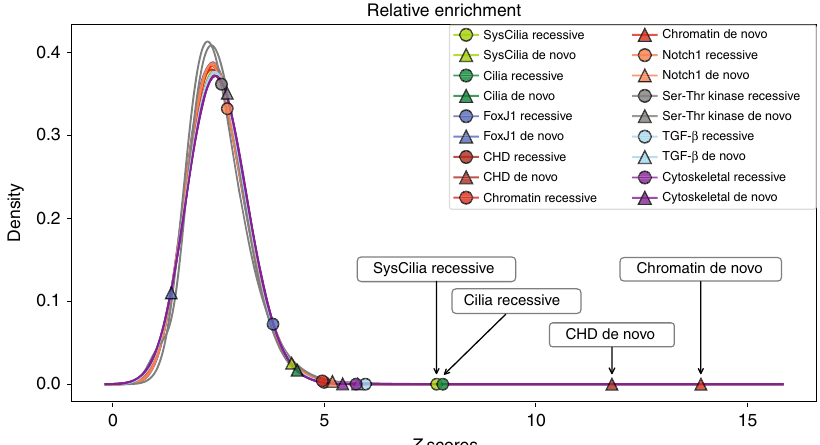
Fig. 5 Relative enrichment of damaging recessive and de novo variation in CHD patients. To compare the fi ndings among the distributions shown in Figs. 3 and 4, each distribution was normalized by Z -score transformation. Recessively inherited damaged genotypes found in SysCilia and Cilia genes are highly enriched in CHD probands ( + 7.7 SDs, p value < 1e-5). These genes show only marginal enrichment for de novo mutations as compared to the enrichment seen for damaging recessive genotypes. In contrast, there is strong enrichment for de novo mutations in chromatin-modifying and known CHD genes ( + 14.0 and + 17.1 SDs , respectively, p value < 1e-5) but relatively moderate enrichment for damaging recessive genotypes. Other gene lists representing the Notch pathway, the TGF- β signaling pathway, and cytoskeletal genes are also moderately enriched ( + 4.0 to + 5.2 SDs), suggesting an important but more limited contribution to CHD as compared to cilia and chromatin genes. P values are obtained by permutation of the transformed distributions